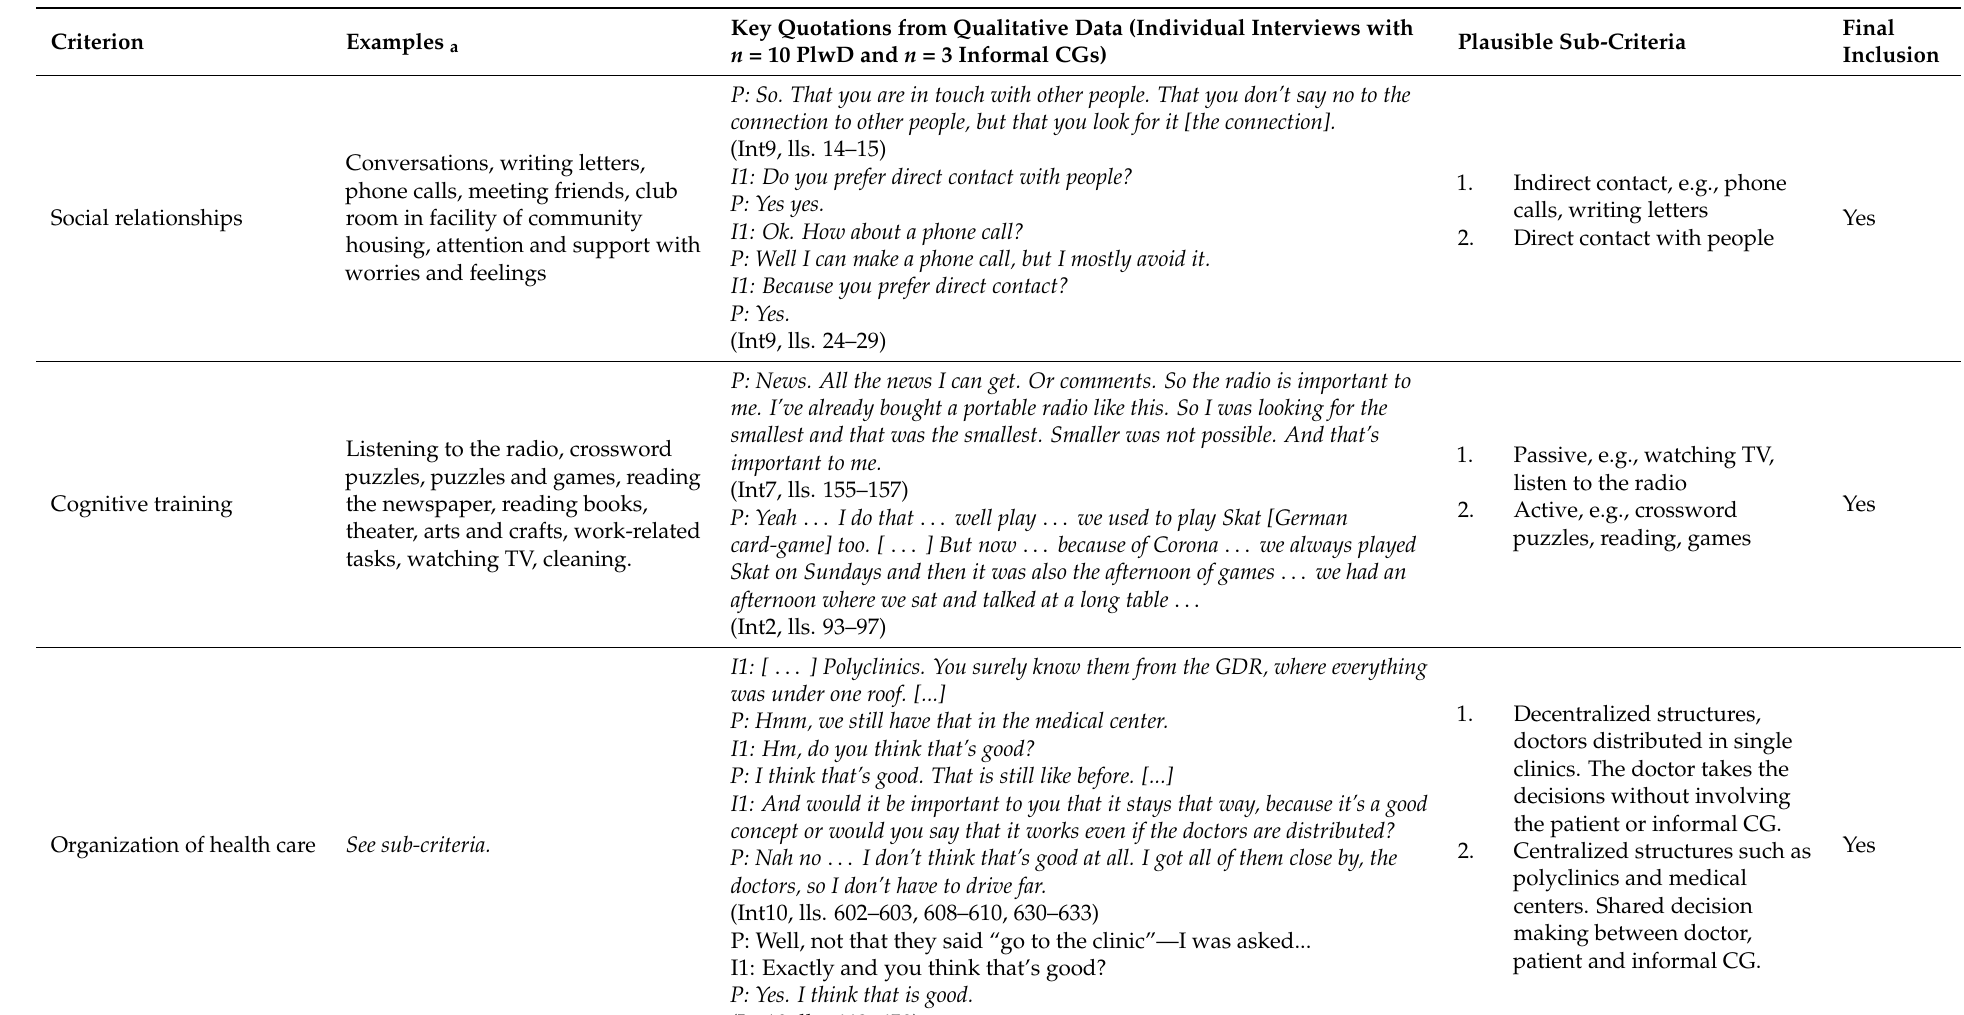
Table 3. Derivation of list of AHP criteria and plausible sub-criteria (ordered from most preferred to least per card game results). Key Quotations from Qualitative Data (Individual Interviews with Criterion Examples a n = 10 PlwD and n = 3 Informal CGs)